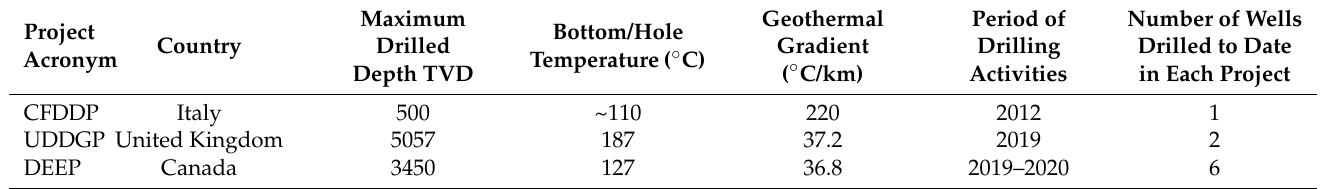
Table 2. Summary of the main characteristic of the three geothermal drilling projects considered.